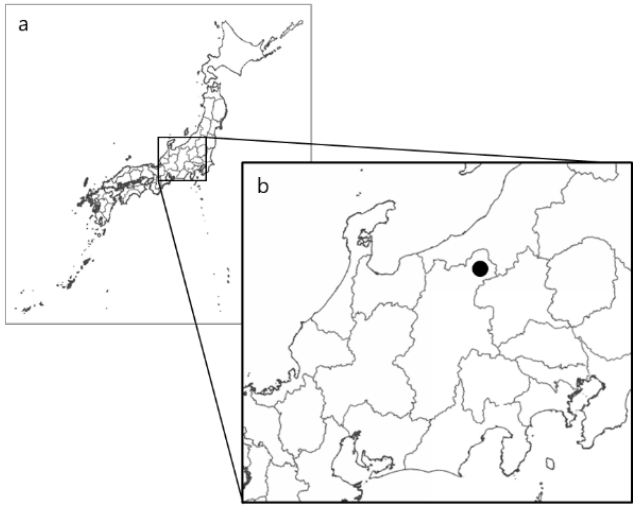
Figure 1. Map of ( a ) Japan and ( b ) the study site location. A 1 ha research plot was established in the study area in 2005. The plot was registered as one of the core sites for the Monitoring Sites 1000 Project [21]. As part of this project, all living trees in the study area with a girth of breast height (GBH) of ≥ 15 cm are surveyed annually, and their position, species, and GBH are